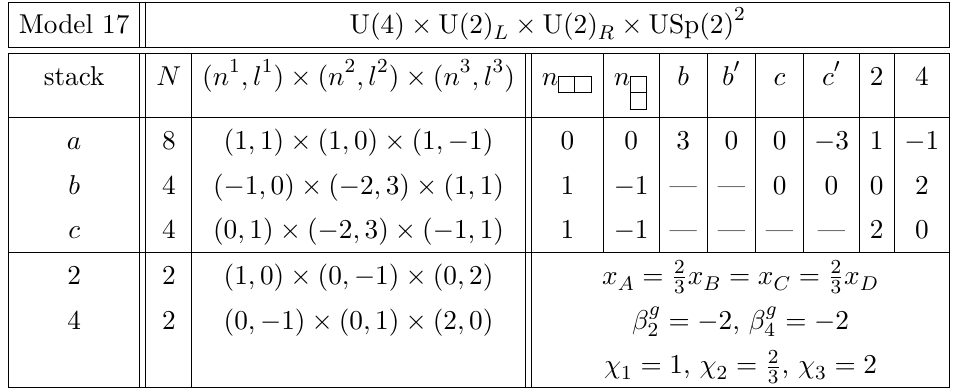
Table 24 . D6-brane configurations and intersection numbers of Model 17, and its MSSM